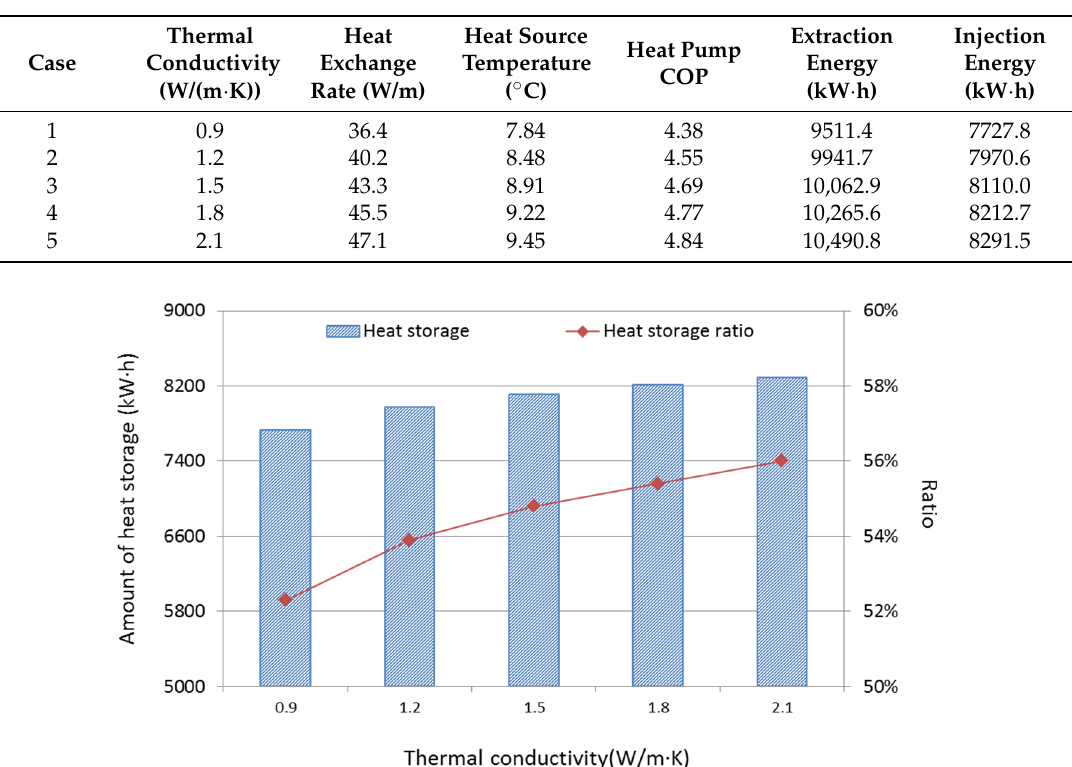
Figure 13. Simulation result of injection solar energy and storage ratio.